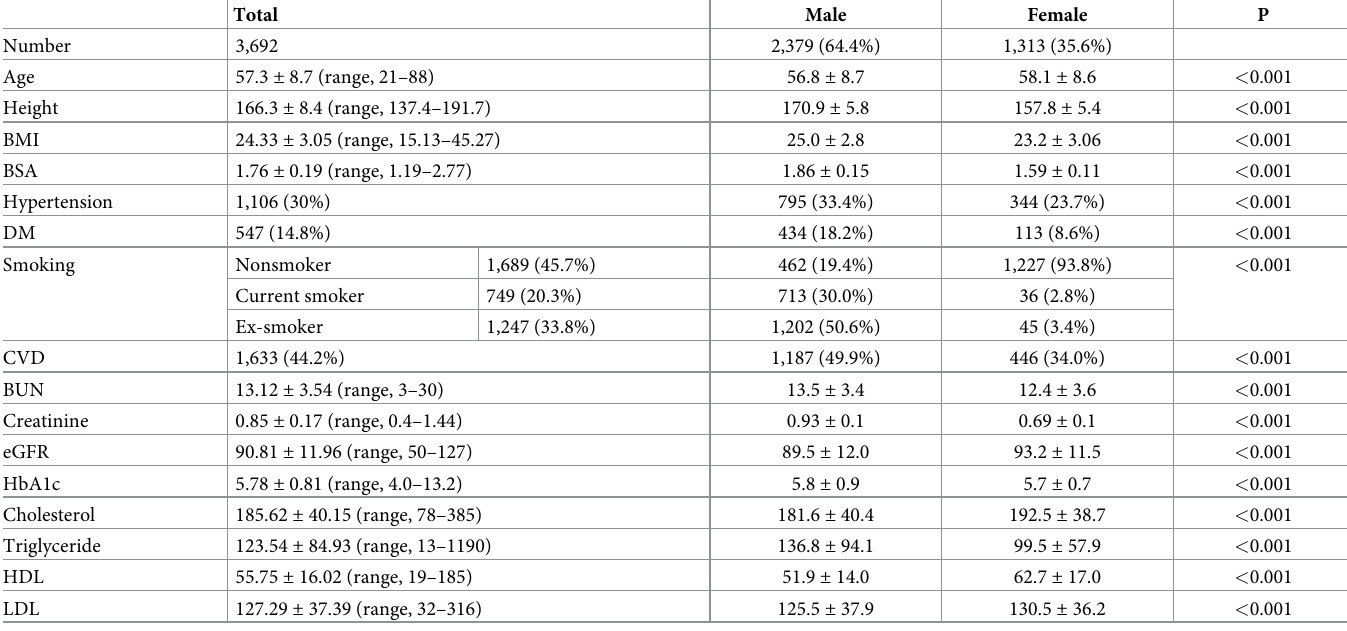
Table 1. Patients’ demographic